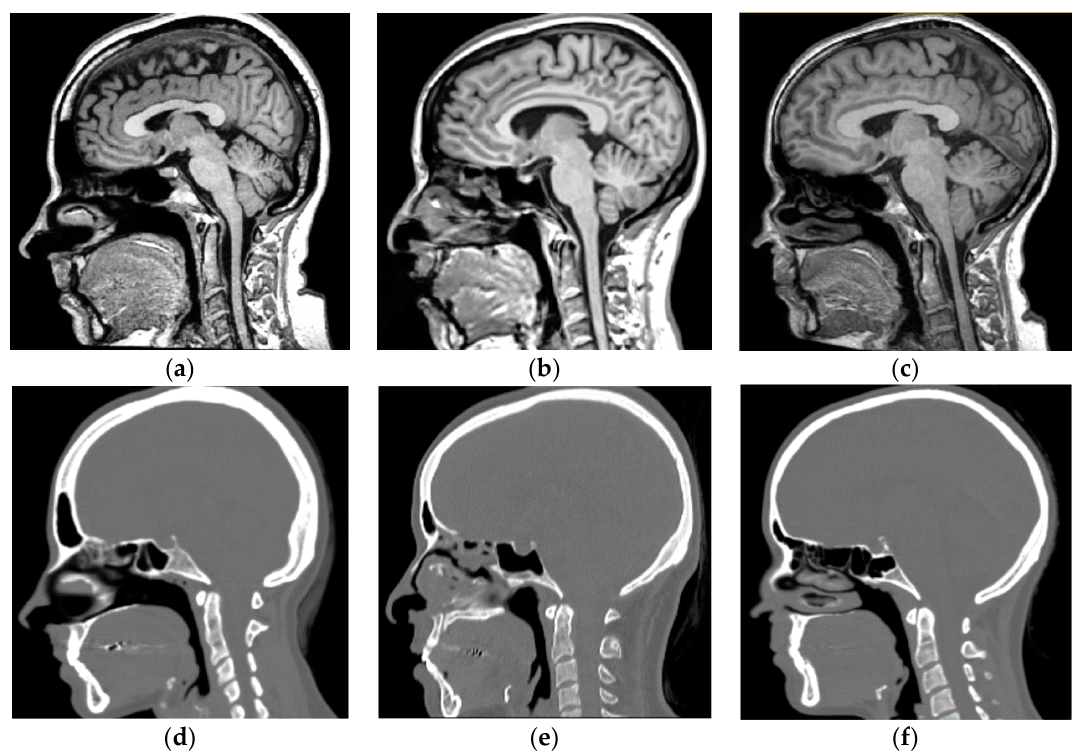
Figure 2. Representative magnetic resonance (MR)-CT pairs from the training dataset showing ( a – c ) full head and neck MRs and ( d – f ) their corresponding paranasal sinuses, facial orbits, and brain CT images, respectively.